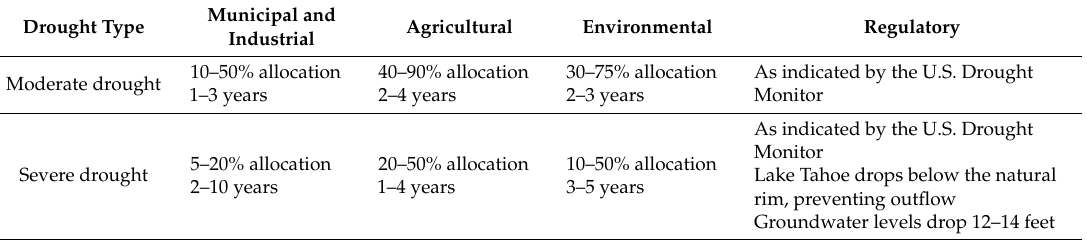
Table 3. Moderate and severe drought defined by water use.